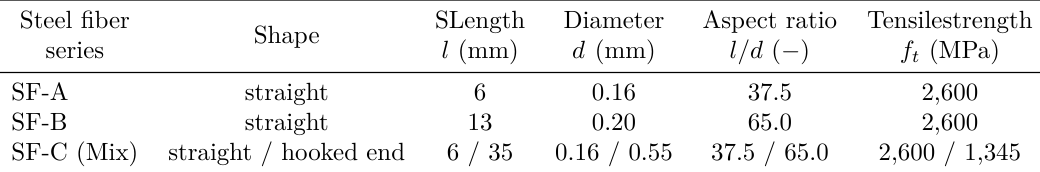
Table 2. Properties of the steel fiber